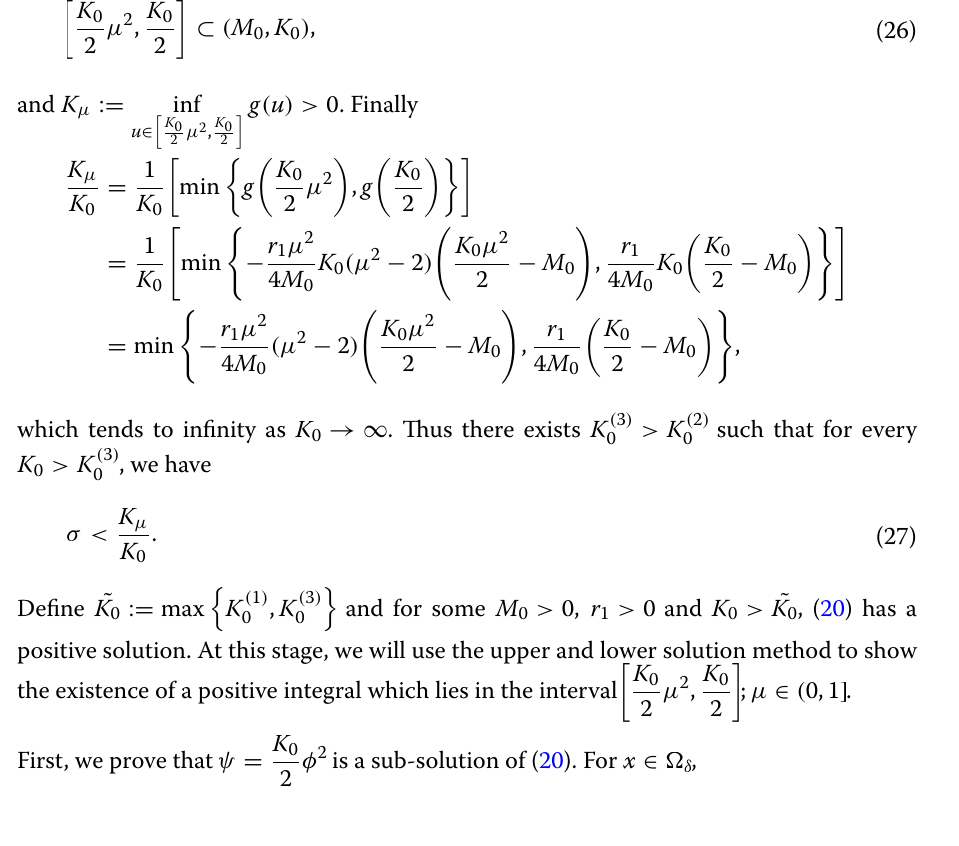
1.2 over the domain (cid:31) =